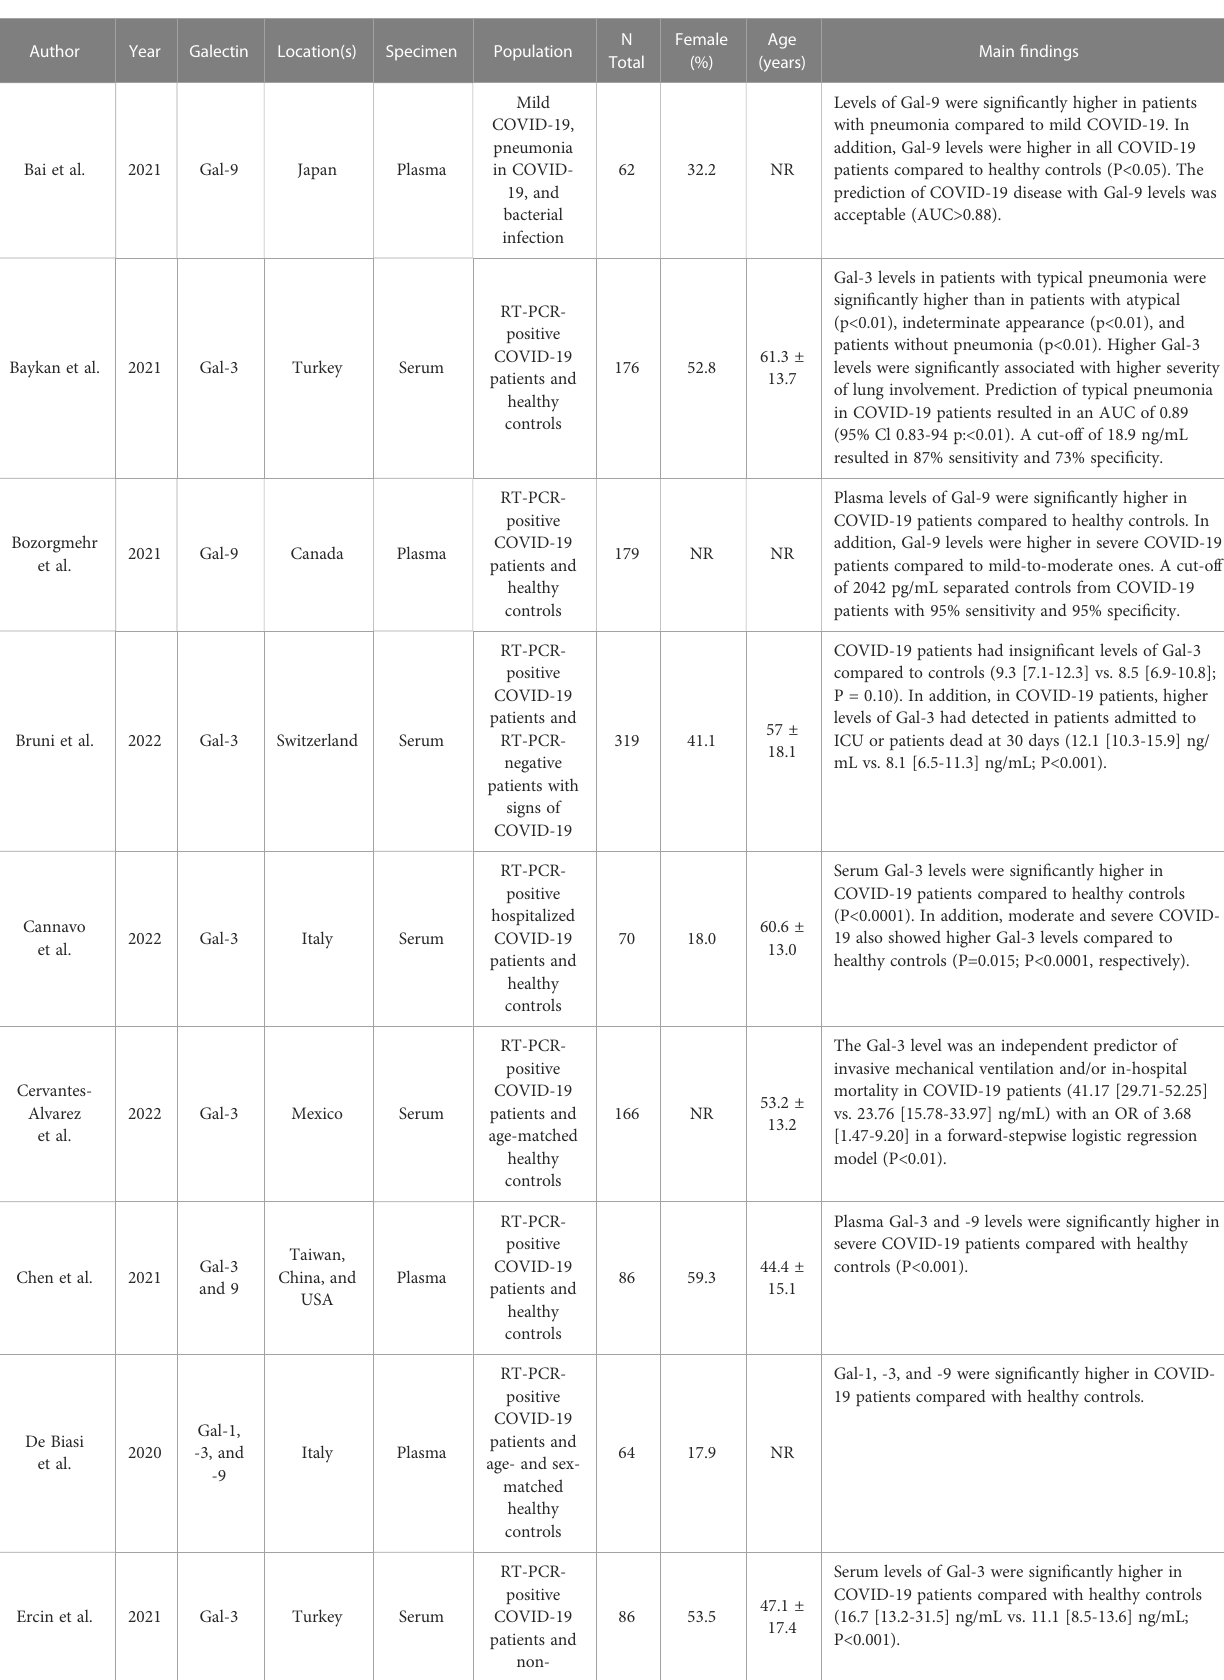
TABLE 1 Main fi ndings and baseline characteristics of included studies.